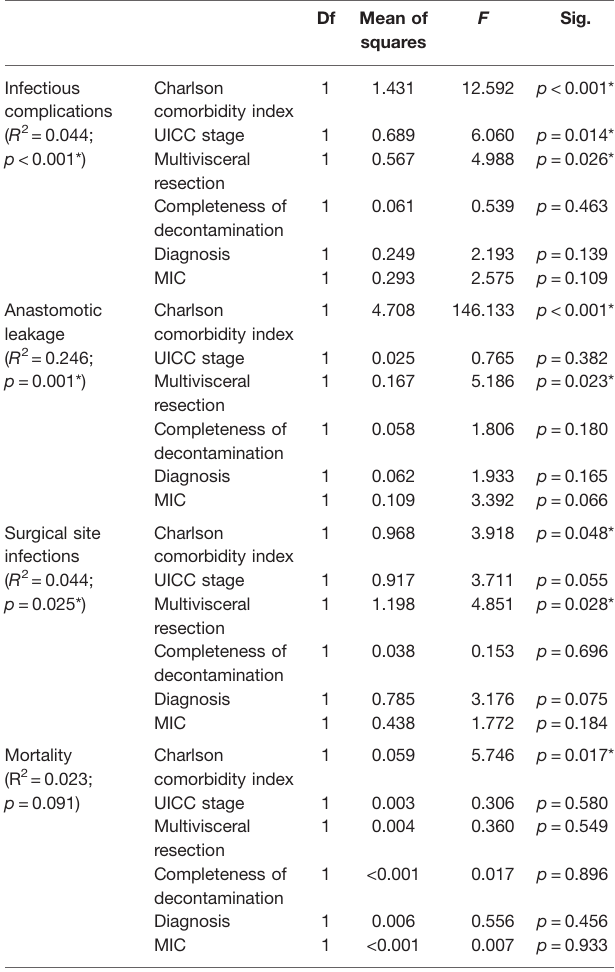
TABLE 4 | Univariate analysis for infectious complications, anastomotic leakage, SSI, and mortality ( p values <0.05 are marked with an *).